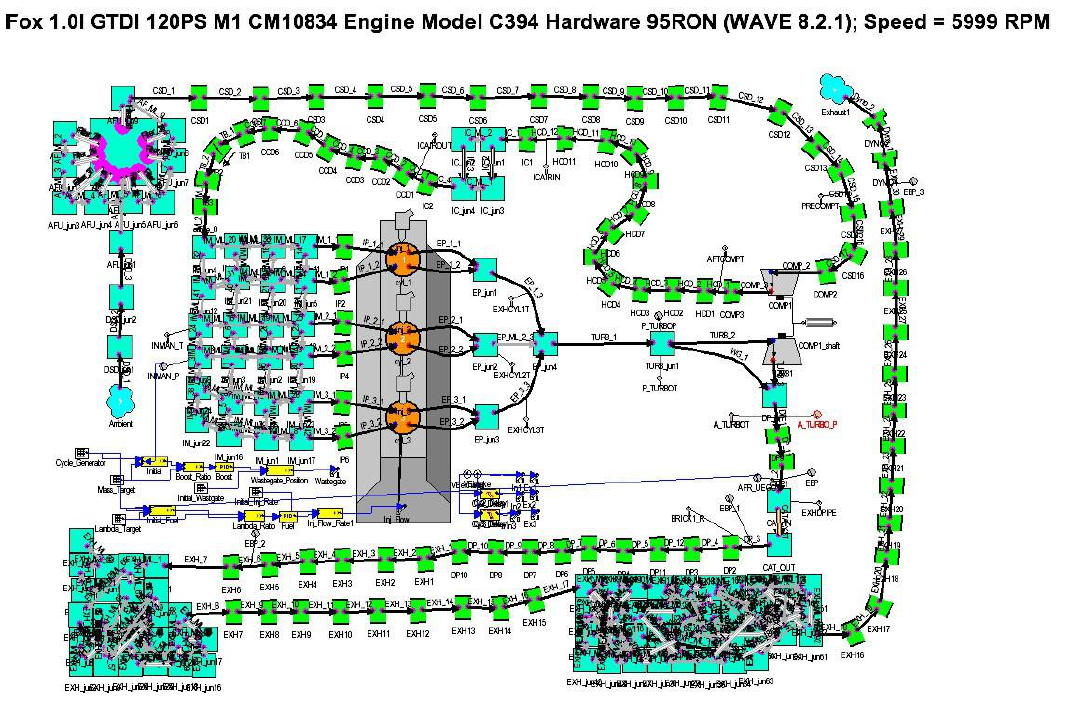
Figure 2. Ricardo Wave Ford engine model.